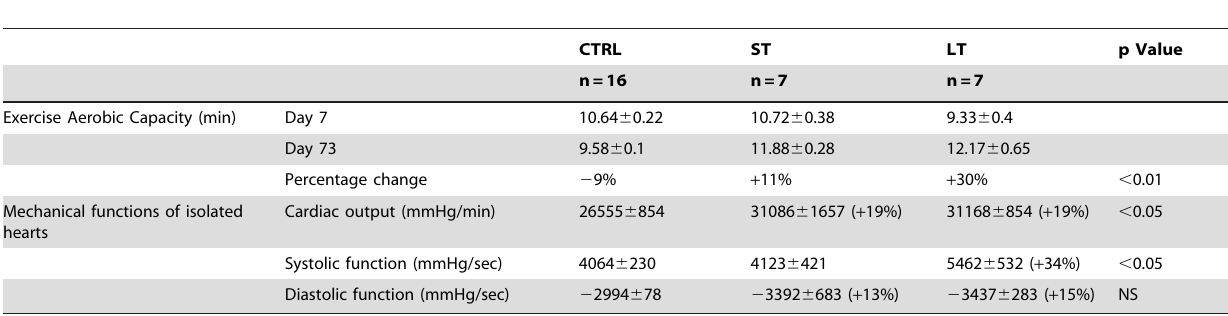
Table 3. The effect of exercise on the in vivo (aerobic exercise capacity) and in vitro (cardiac output, systolic and diastolic function) measurements.